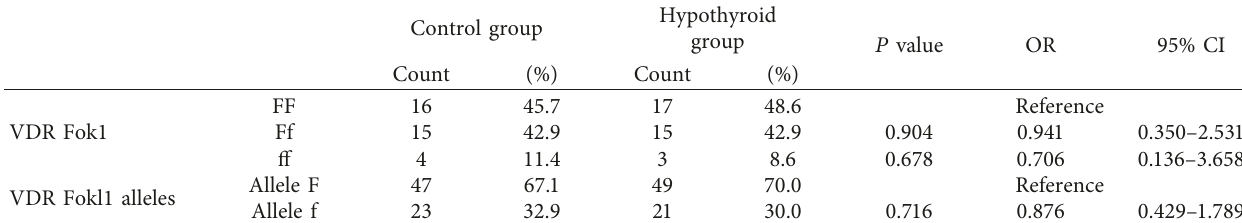
Table 2: Relation between alleles of Fok1 in both